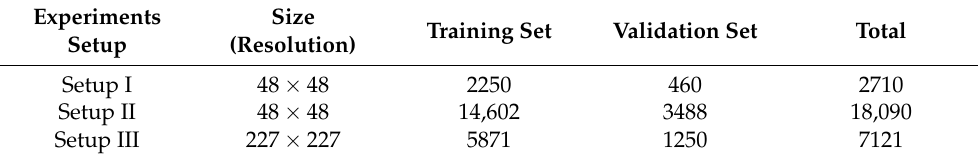
Table 4. Different experimental setups for training and validation.